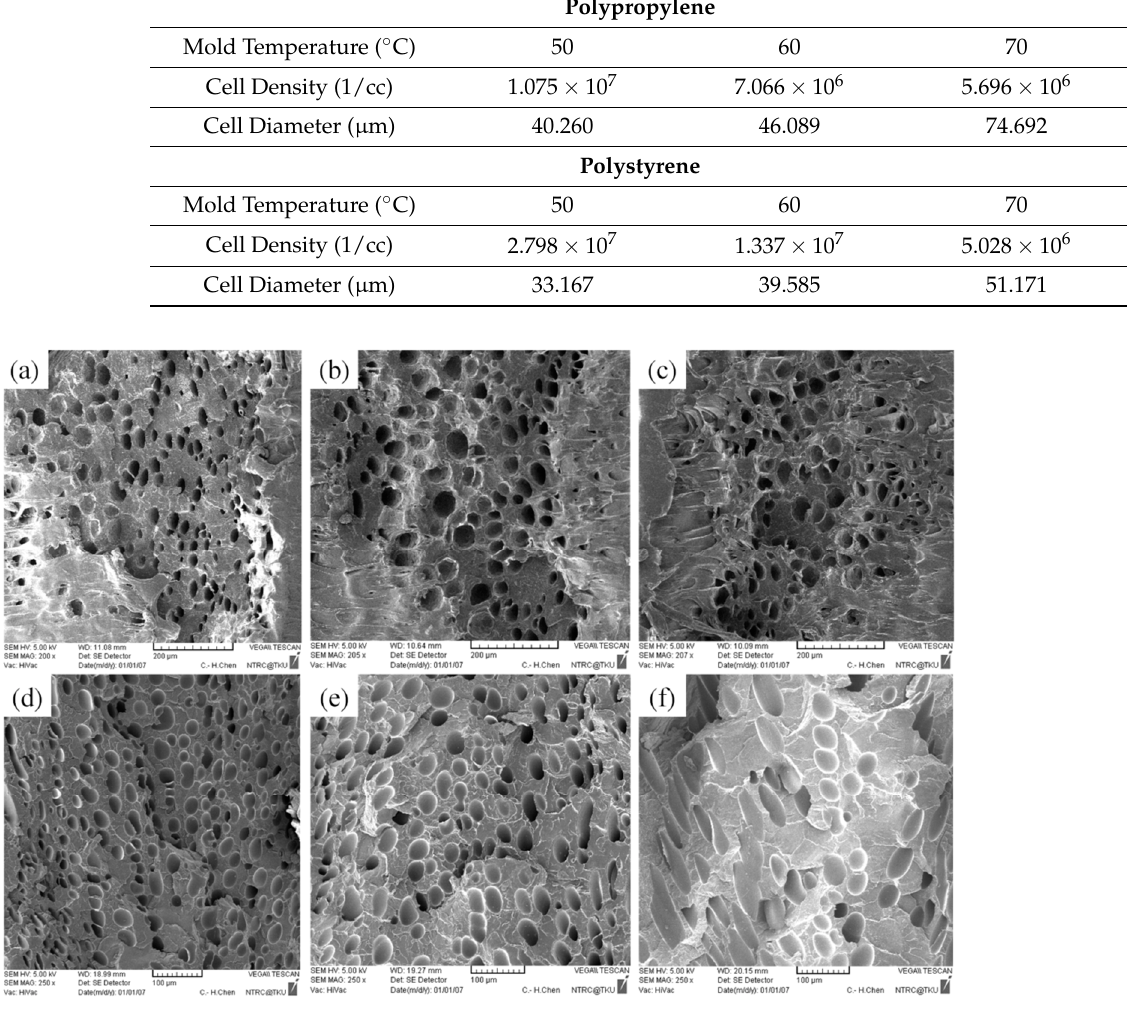
Table 10. Average expansion ratios according to OFAT parameter settings.